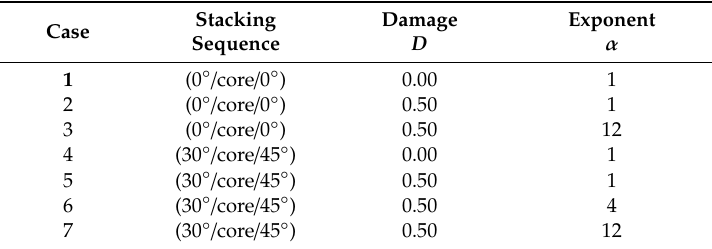
Table 5. Mechanical configurations investigated to show the variation of the mode shapes due to the stacking sequence, the damage parameter and the exponent of the reinforcing fiber